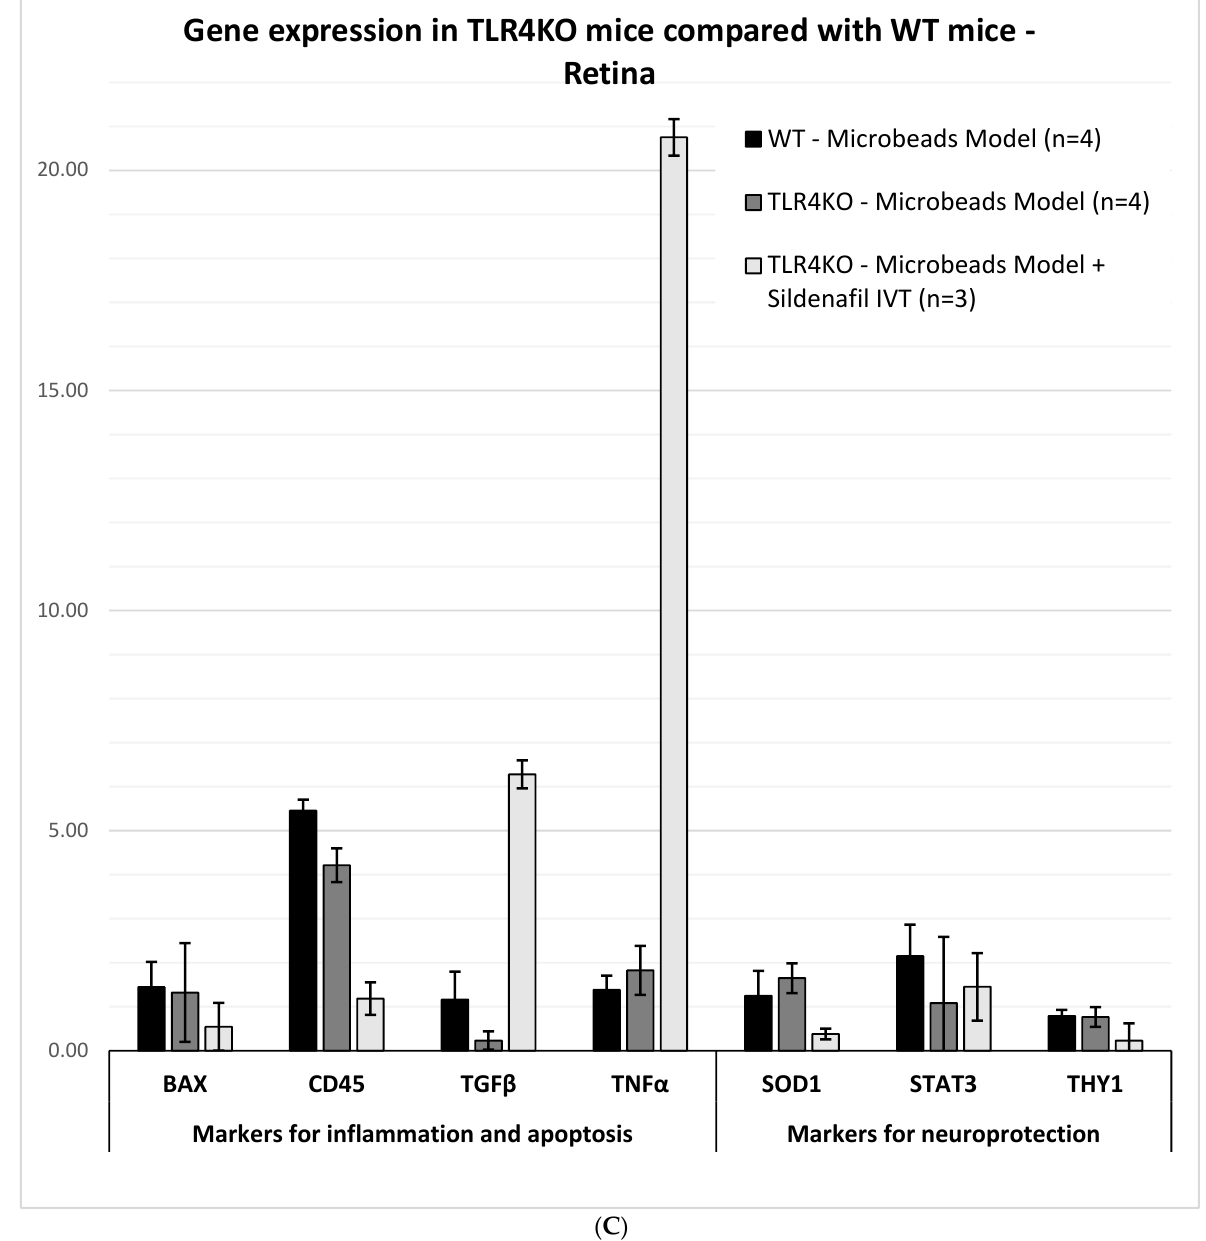
Figure 4. ( A ) Fold changes in gene expression (mean and SD) by treatment group: WT mice, retina. BAX increased in glaucoma-induced (model) eyes and decreased with AZ or sildenafil treatment. CD45 markedly increased in model eyes, and less or not at all with AZ or sildenafil treatment, re- spectively. TGF β and TNF α remained at baseline levels in untreated and AZ-treated eyes, and in- creased in sildenafil - treated eyes. There was no effect on elevated STAT3 in all groups. SOD1 mildly decreased with AZ treatment and further decrease d with sildenafil treatment. THY1 slightly de- creased in model eyes, markedly decreased with AZ treatment, and increased with sildenafil treat- ment. ( B ) Fold changes in gene expression (mean and SD) by treatment group: WT mice, optic nerve . BAX increased in glaucoma-induced eyes with no change with treatment. CD45 remained at base- line in model eyes and increased with AZ or sildenafil treatment. TGFβ remained at baseline in model eyes and decreased with AZ or sildenafil treatment. TNFα was elevated in model eyes and normalized with AZ but not with sildenafil treatment. SOD1 mildly decreased with AZ or sildenafil treatment. STAT3 mildly increased in model eyes, normalized with AZ treatment, and further de- creased with sildenafil treatment. There was a marked elevation in BCL2 with AZ and sildenafil treatment. ( C ) Fold changes in gene expression (mean and SD) by treatment group: TLR4KO mice, retina, including a comparison to retinas of model eyes in WT mice . Sildenafil reduced the levels of